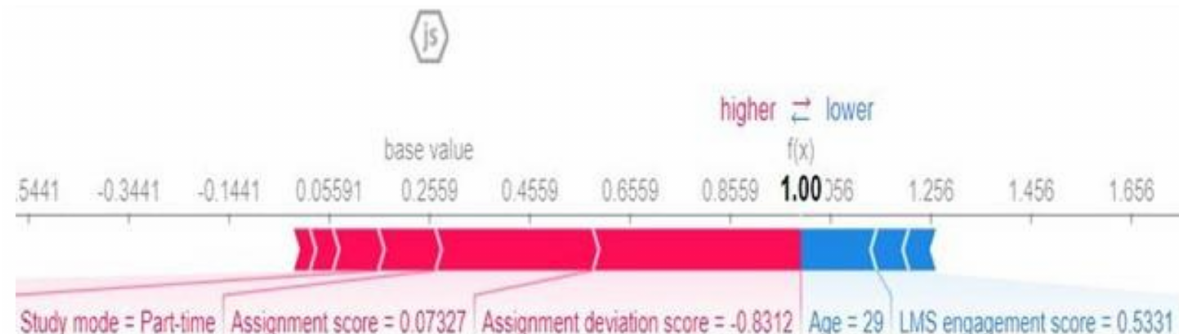
Figure 4. Shapley force plot of a